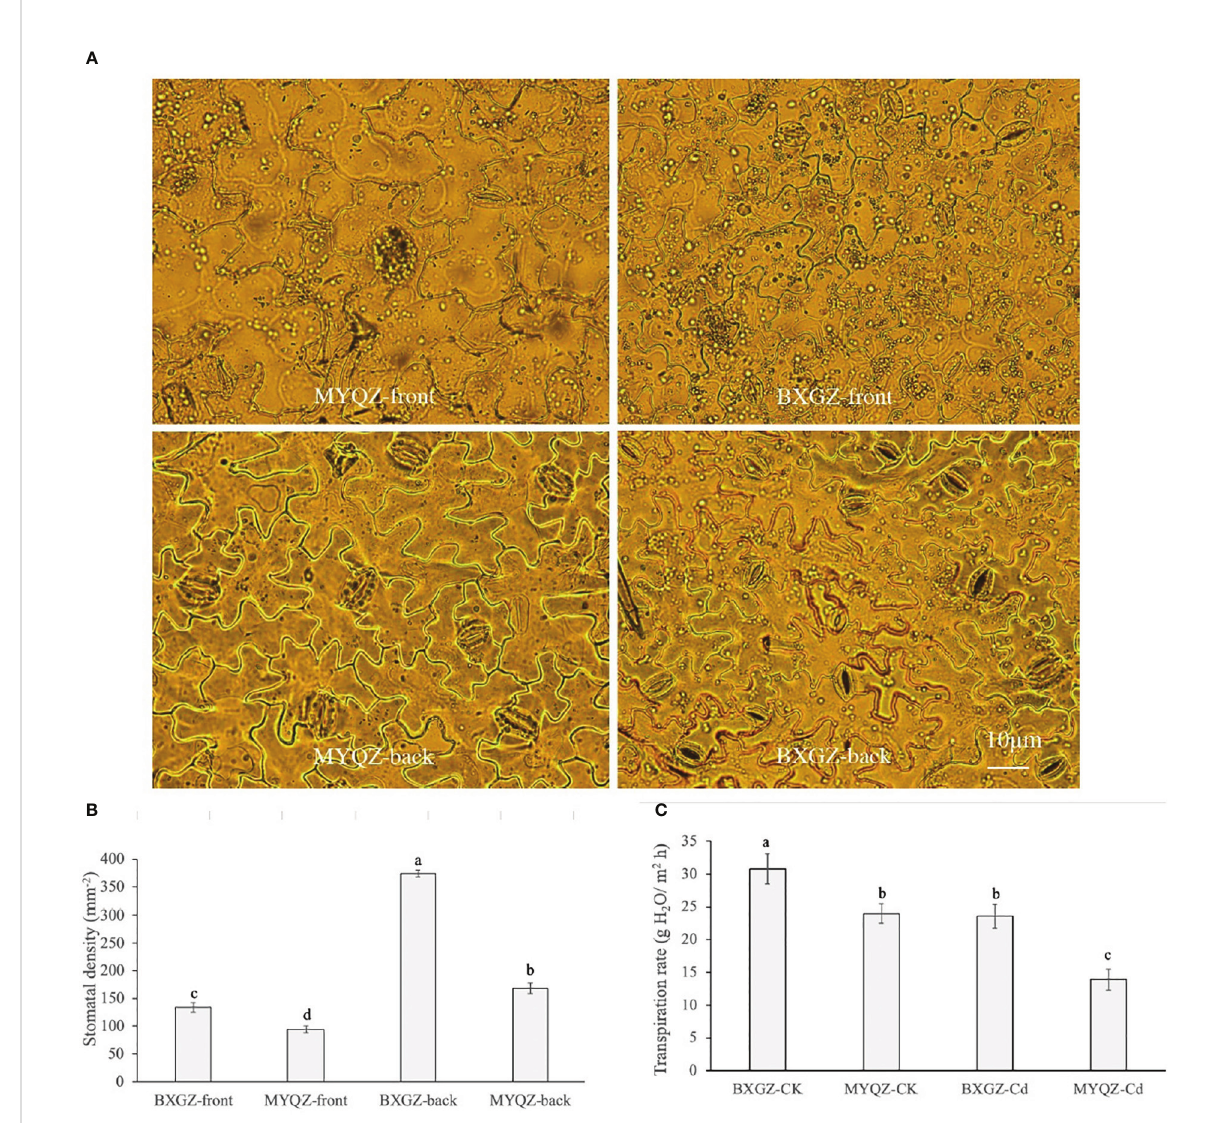
FIGURE 4 The micrographs of front and back epidermis (A) , stomatal density (B) , and transpiration rate (C) of BXGZ and MYQZ. Values are the mean ± standard error (n = 3). Different small letters indicate signi fi cant differences ( p < 0.05) among the four